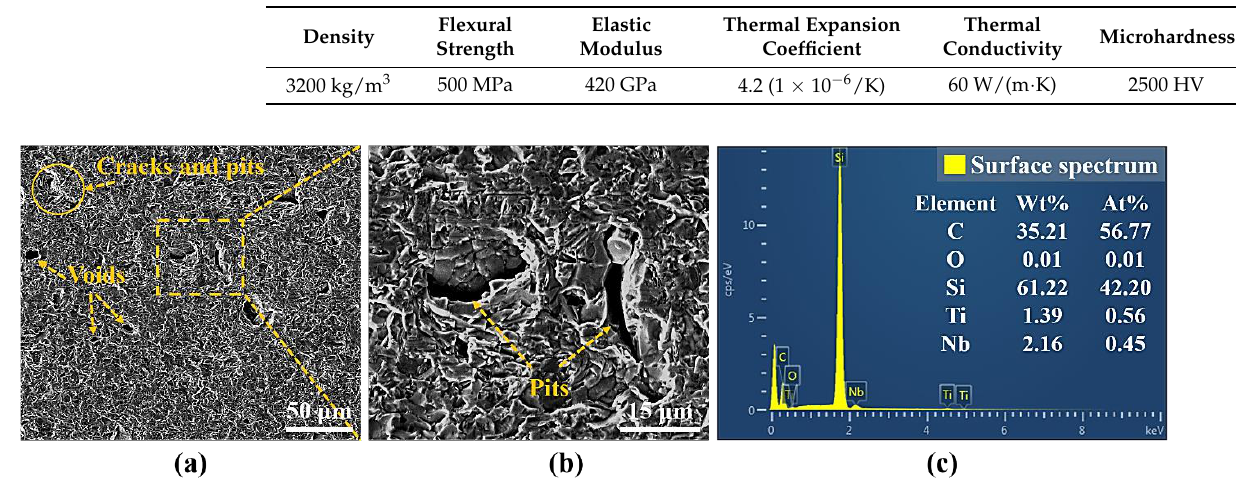
Figure 1. The SEM images and EDS element analysis of the initial surface. ( a ) The initial surface topography, ( b ) the partial enlarged details of the inset ( a , c ) the EDS elemental analysis of the inset ( b ).